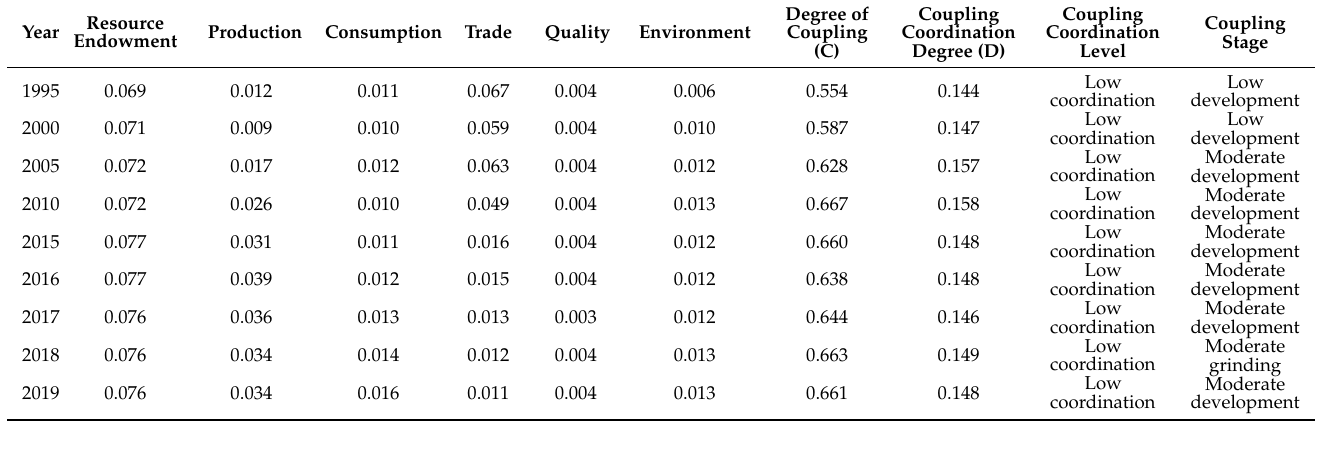
Table 4. Coupling coordination state of the subsystems of China’s beef cattle industry, 1995–2019.